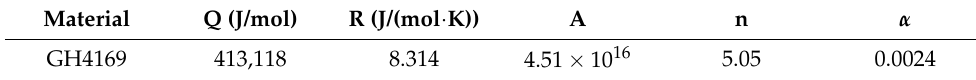
Figure 8. Convective heat transfer coefficient curves used in FE simulations: ( a ) air cooling; ( b ) oil cooling; ( c ) water cooling. Table 2. Value of parameters in the constitutive model.